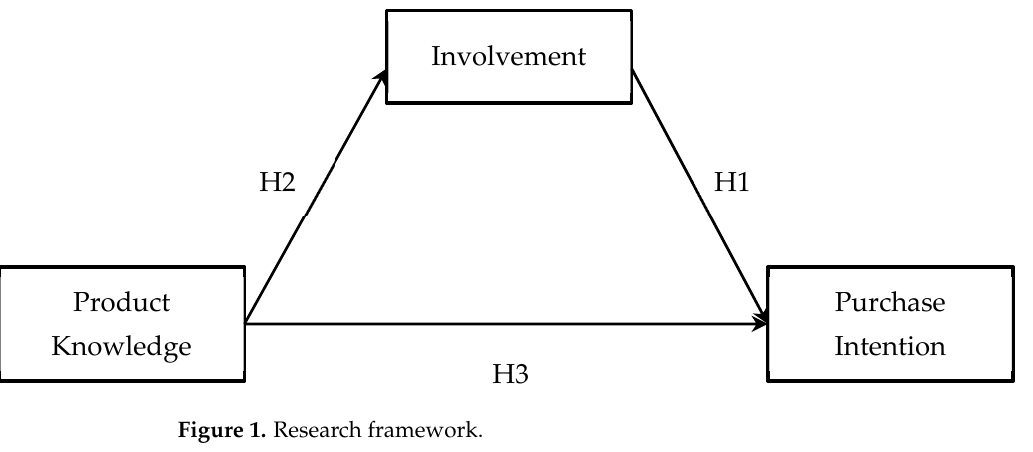
Figure 1. Research Figure 1. Research framework.